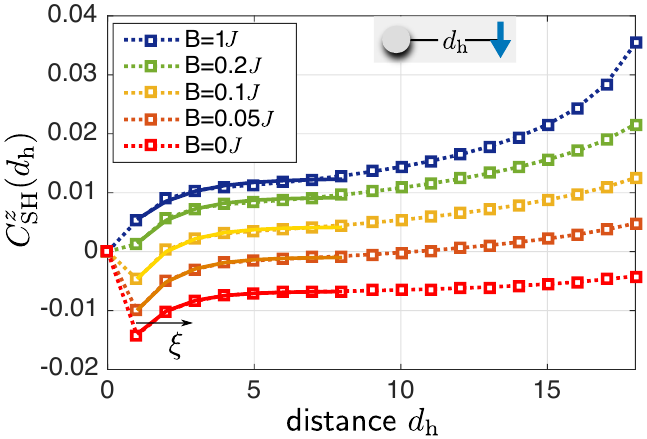
Figure 7: Pinning long-range order. We use DMRG to calculate the two-point ( d ) , see Eq. (6), in a 40 × 3 system with open boundary conditions for function C z h SH = L / 2. The procedure is identical to the one described in Fig. 3 (a) of the main j x 0 text, but we tune the strength of the staggered magnetic field B which is applied at the short edges of the system to pin the AFM order, see Fig. 3 (c). The two-point function shows a pronounced dip at short distances d on the applied pinning field B . To extract the characteristic length scale associated with the dip, we performed fits of the form A (solid